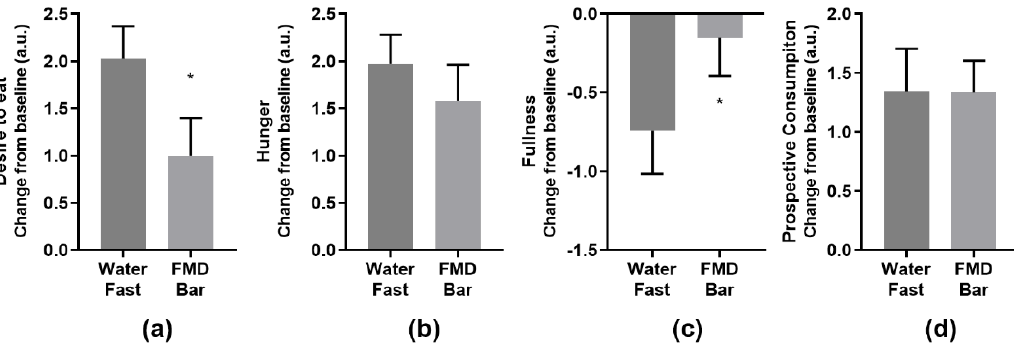
Figure 3. Changes in subjective measures at 3 h post FMD bar consumption: ( a ) “How strong is your desire to eat?”; ( b ) “How hungry do you feel?”; ( c ) “How full do you feel?”; ( d ) How much food do you think you could eat?”. * p < 0.05, unpaired, nonparametric, one − tailed, Mann − Whitney test comparing FMD group to the water fast group.